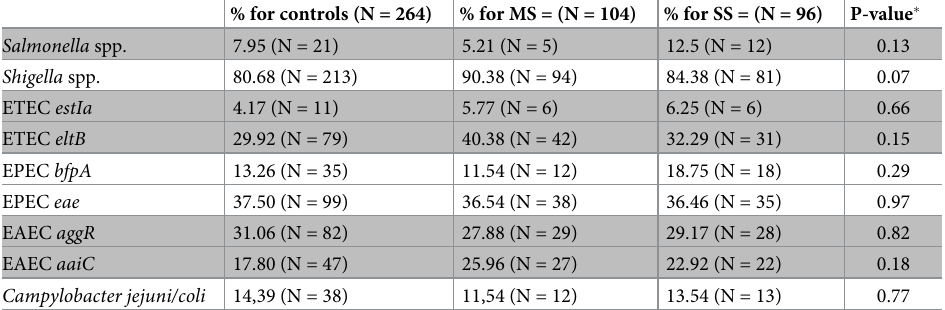
%: percentage; N: total number of sample analysis; MS: moderately stunted; SS: severely stunted; Comparisons between groups (controls and stunted children MS+SS) were determined using Pearson’s χ 2-test or Fisher’s exact test, as appropriate. Only values with p < 0.05 could be considered to be statistically significant �